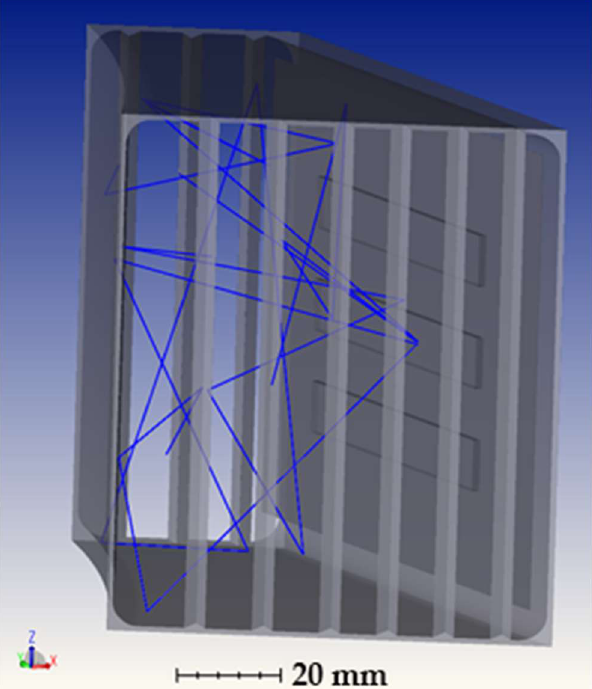
Figure 2. The model of the disinfection chamber in Zemax Optic Studio showing the triangular extrusion light baffles, PCB placement and reflectors. One LED is shining showing the way light is scattered inside.